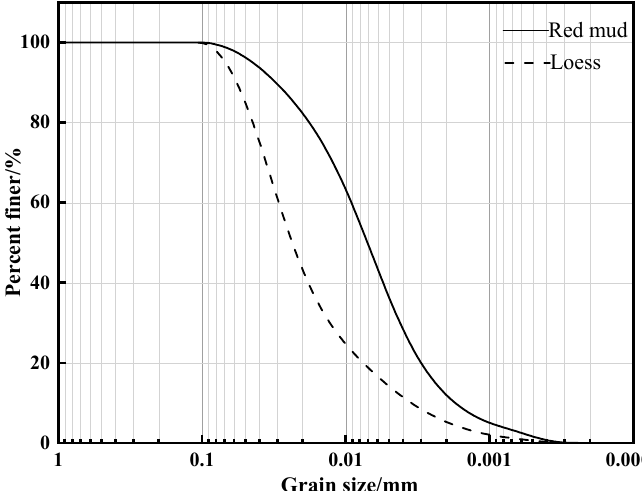
Figure 2. Particle size distribution of red mud and loess.